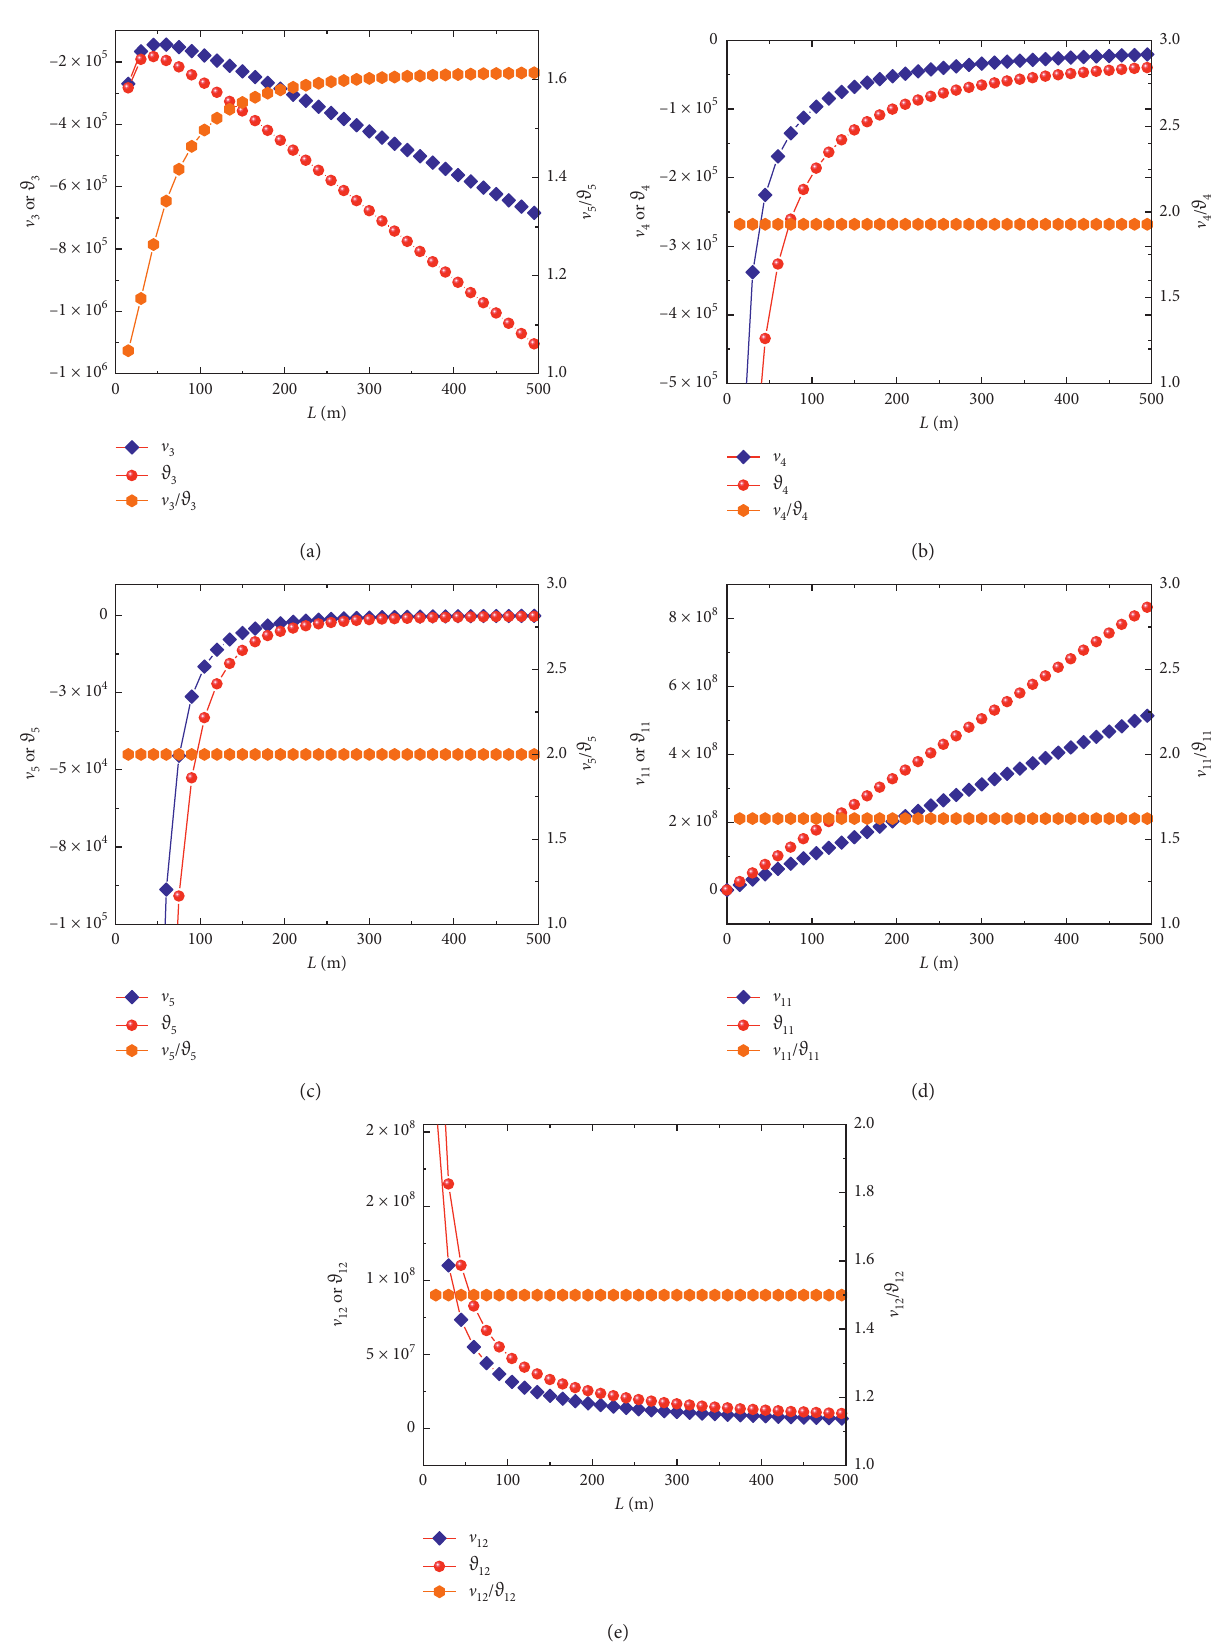
Figure 3: Influences of span length on coefficients: (a) coefficients of ] coefficients of ]